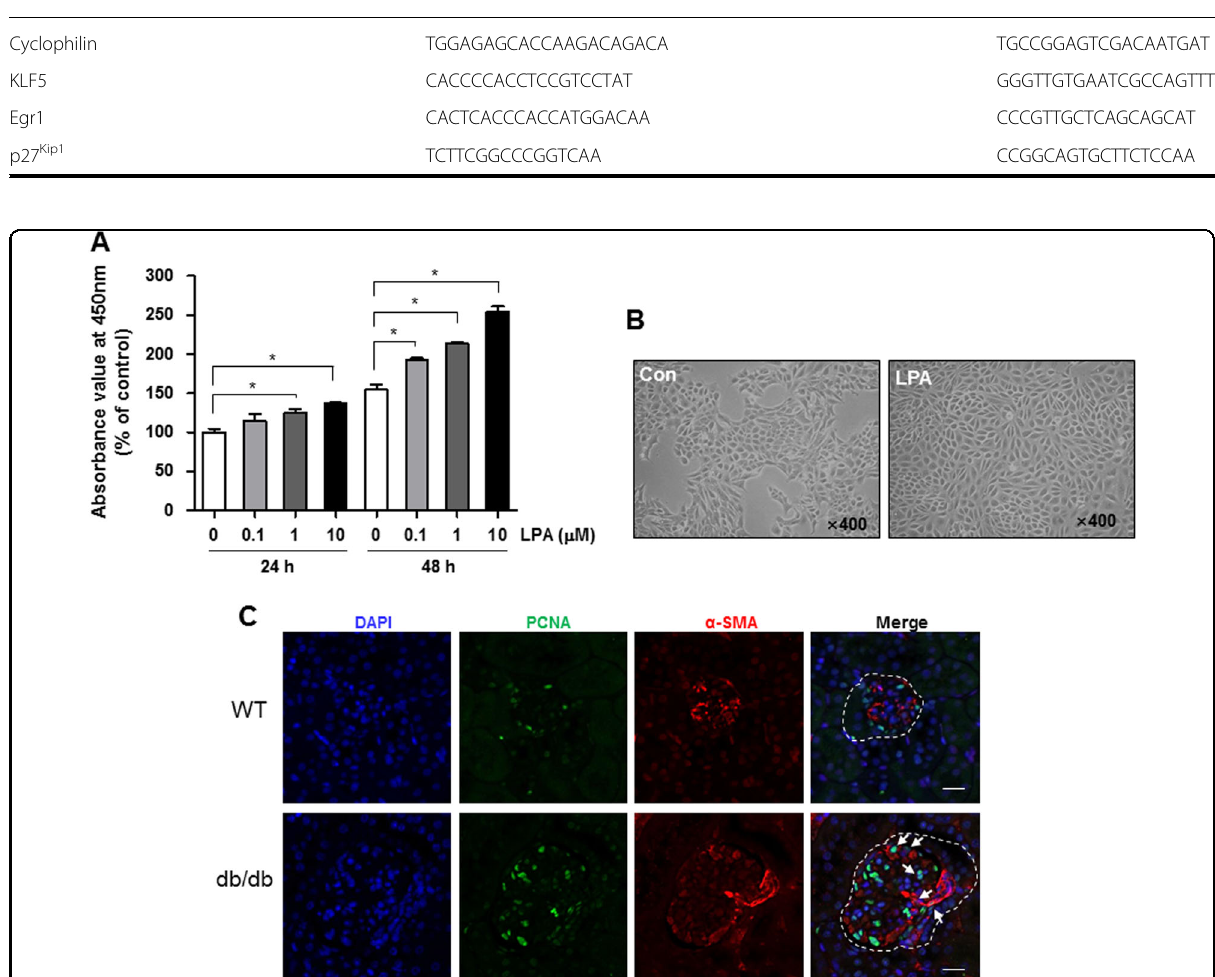
Fig. 1 LPA increases SV40 MES13 cell proliferation. SV40 MES13 cells were plated and starved in serum-free medium containing 0.1% fatty acid- free bovine serum albumin. a Cells were treated with LPA at a fi nal concentration of 0.1, 1, or 10 μ M for 24 or 48 h. Cell proliferation was examined using the CCK-8 assay ( n = 3 independent experiments). b The morphology of control (Con) and LPA-treated (10 μ M) cells was examined using light microscopy (original magni fi cation, × 400). c Representative images showing the colocalization of α -SMA (red) and PCNA (green) in kidney sections from 9-week-old db/db mice and age-matched wild-type (WT) mice. Nuclei were counterstained with DAPI (blue). Dashed line, kidney glomeruli; arrows, costained cells; scale bars, 20 μ m; n = 3 – 4; * p < 0.05. Data are presented as means ±